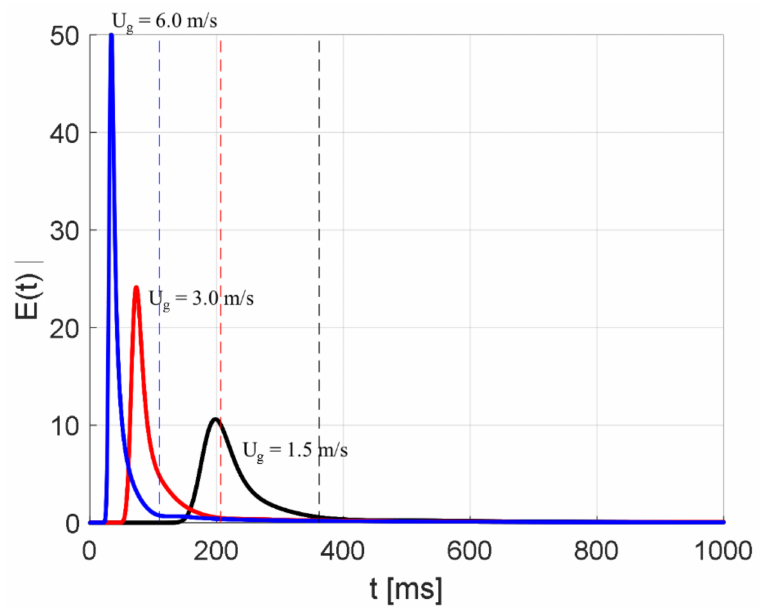
Figure 5. Dimensionless residence time distributions, E(t) , for the three cases, U g = 1.5 m/s ( black ), 3.0 m/s ( red ) and 6.0 m/s ( blue ). Dashed lines show the mean residence time for the three cases